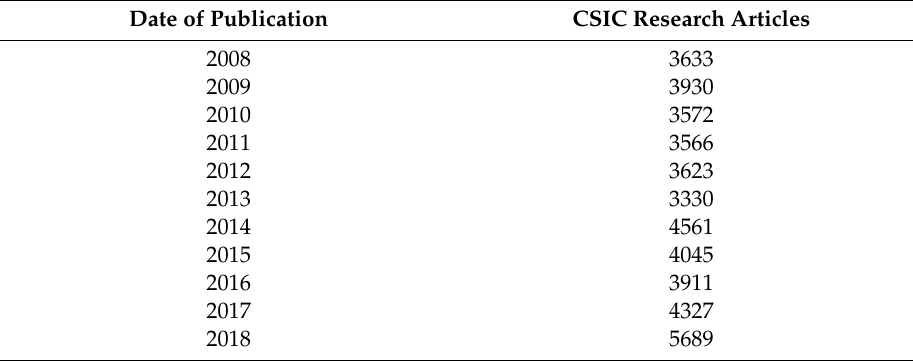
Table 7. Volume of CSIC research articles that could be made Open Access via repository deposit. Source: Sherpa Romeo.